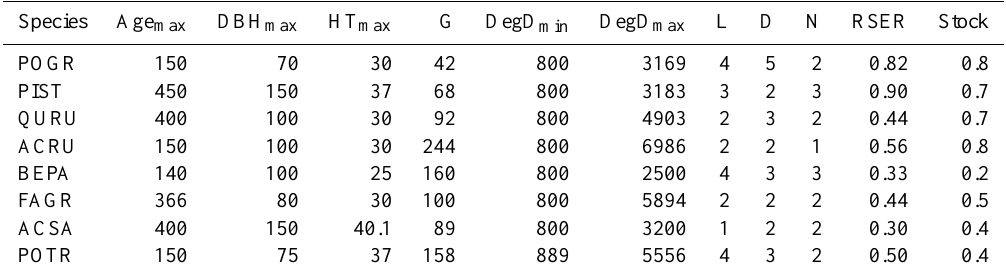
Table 3. Species-specific allometric and ecological parameters for the eight tree species used in ZELIG, representing species found in the upper Great Lakes. Species shown include Populus grandidentata (POGR), Betula papyrifera (BEPA), Quercus rubra (QURU), Pinus strobus (PIST), Acer saccharum (ACSA), Acer rubrum (ACRU), Populus tremuloides (POTR), and Fagus grandifolia (FAGR). All species were assigned a probability factor of stress mortality of 0.369, a probability factor of natural mortality of 2.408, and a zone of seed influence